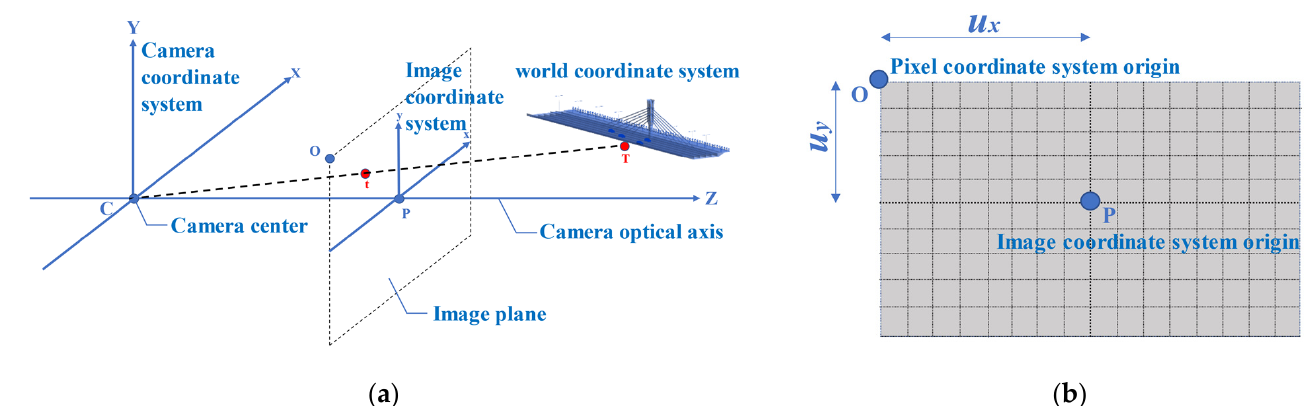
Figure 2. ( a ) Relationship among the camera coordinate system, the image coordinate system, and the world coordinate system; and ( b ) Relationship between the pixel coordinate system and the image coordinate system.